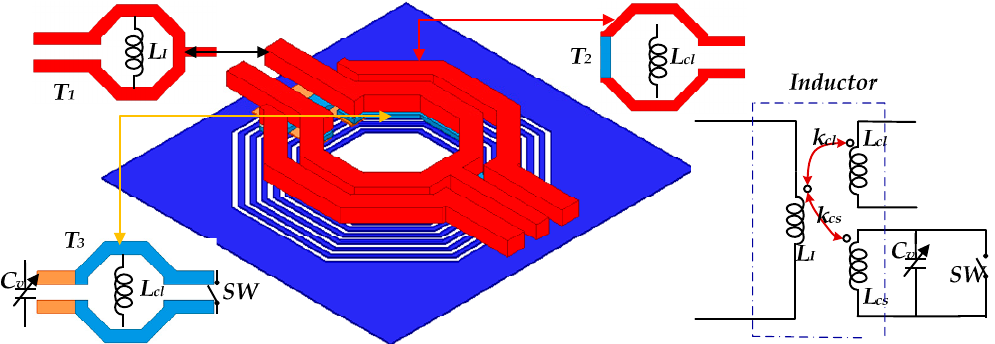
Figure 2. The presented differential low negative coupling shield switch (DLNCSS) inductor and its equivalent model.